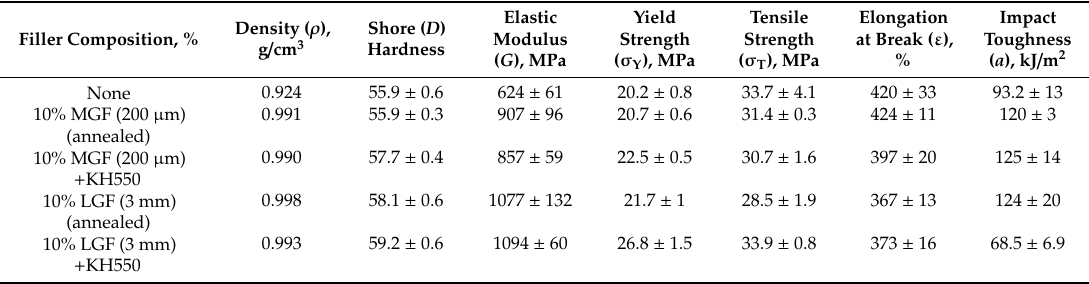
Table 4. Mechanical properties of GUR 4120 and GUR 4120-based composites.